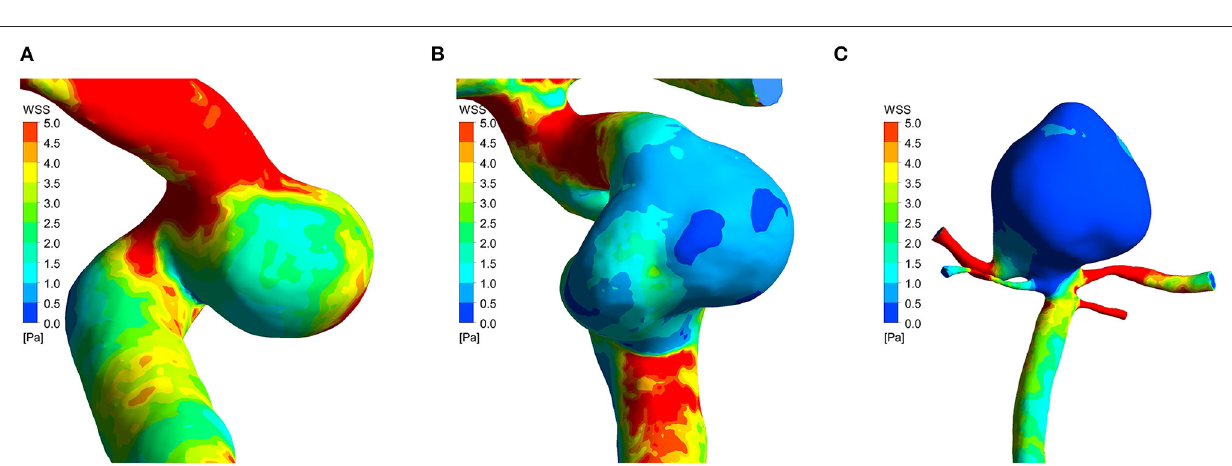
FIGURE 2 | Time-averaged wall shear stress distribution maps of three cases in low-risk group (A) , intermediate-risk group (B) , and high-risk group (C) . PHASES score of the three cases was 3, 6, and 11, respectively. The time-averaged wall shear stress progressively decreased as aneurysm rupture risk